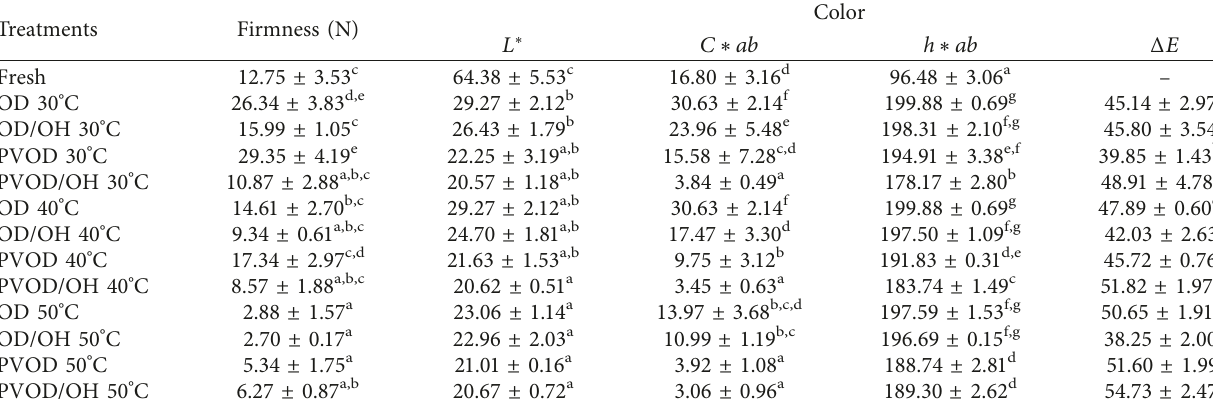
Table 2: Firmness and color determination in fresh and treated apples with three temperatures (30 ° C, 40 ° C, and 50 ° C).